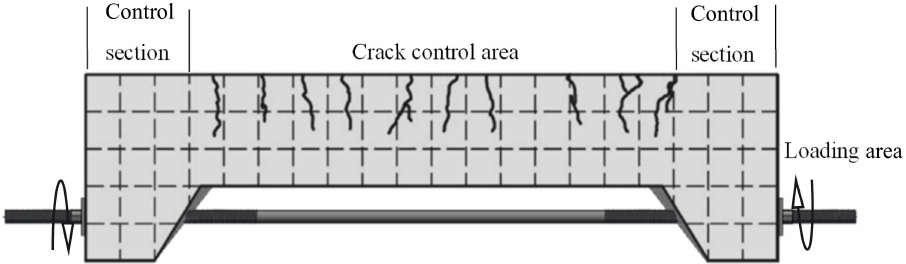
Figure 4. Schematic diagram of test beam